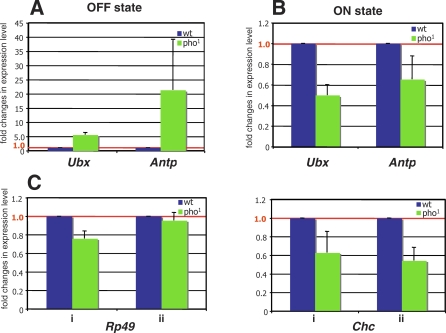
Changes in Transcription Levels of PHO Target Genes in pho1 MutantsFold changes of Ubx, Antp, Rp49, and Chc expression levels in eye, haltere/third leg and wing imaginal discs in pho1 homozygous mutant larvae (green histograms) compared to wild type (wt; blue histograms).(A) Expression of homeotic genes in eye discs, where both Ubx and Antp genes are OFF. (B) Expression of homeotic genes in haltere/third leg discs (Ubx) and wing discs (Antp) where genes are ON.(C) Fold changes in expression levels of Rp49 and Chc in eye (i) and haltere/third leg discs (ii). The standard deviation, as indicated by the error bars, was calculated from at least two independent experiments.